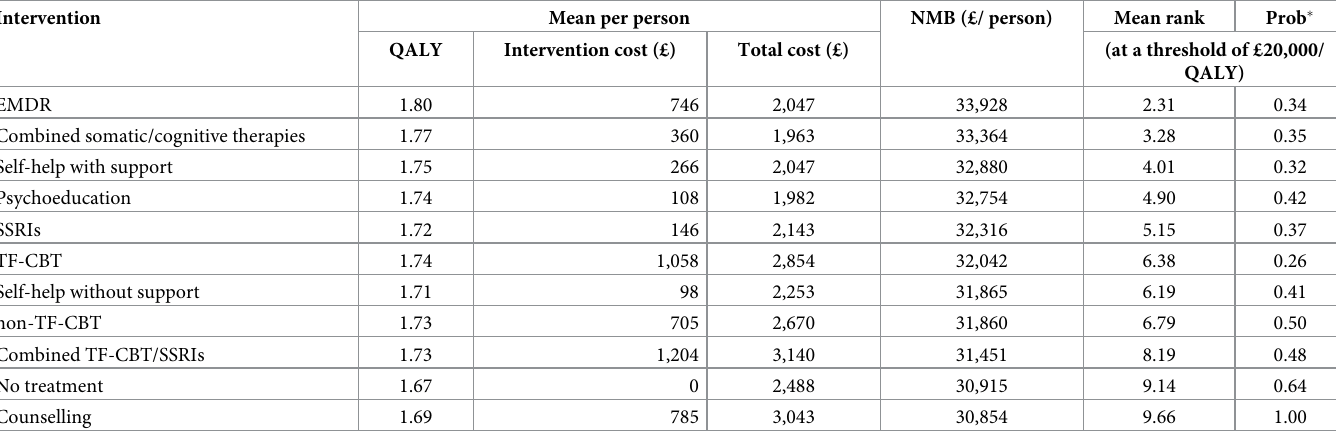
counselling. The probability of EMDR being the most cost-effective treatment amongst the 11 options assessed was only 0.34. The probabilities of cost-effectiveness for next interventions in ranking up to (and including) self-help without support did not exceed 0.42, although increas- ingly fewer interventions were included in the analysis, indicating uncertainty in the results. Notably, counselling was less cost-effective than no treatment; this finding was attributed to the relatively low clinical effectiveness of counselling (the lowest amongst all active treatments assessed in the economic analysis), which did not offset its relatively high intervention cost. The cost-effectiveness plane (Fig 2) depicts the mean incremental costs and QALYs of all inter- ventions versus no treatment (placed at the origin). According to the cost-effectiveness accept- ability frontier (Fig 3), combined somatic/cognitive therapies appeared to be most cost- effective amongst the 11 treatment options assessed for thresholds up to £2,500/QALY, with a low probability that reached 0.25 at maximum, whereas EMDR became the most cost-effective option at higher thresholds, with a probability that ranged from 0.19 to 0.41 amongst the 11 options assessed. Results of the secondary analysis, which utilised 3-month NMA follow-up data, were not very different. The top 3 interventions (EMDR, combined somatic/cognitive therapies, self- Table 3. Base-case results of economic